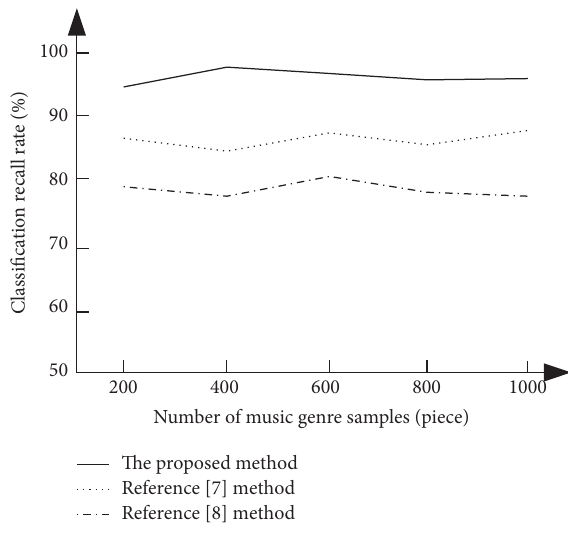
Figure 8: Comparison results of recall rates of automatic classi- fication of music genres by different methods.